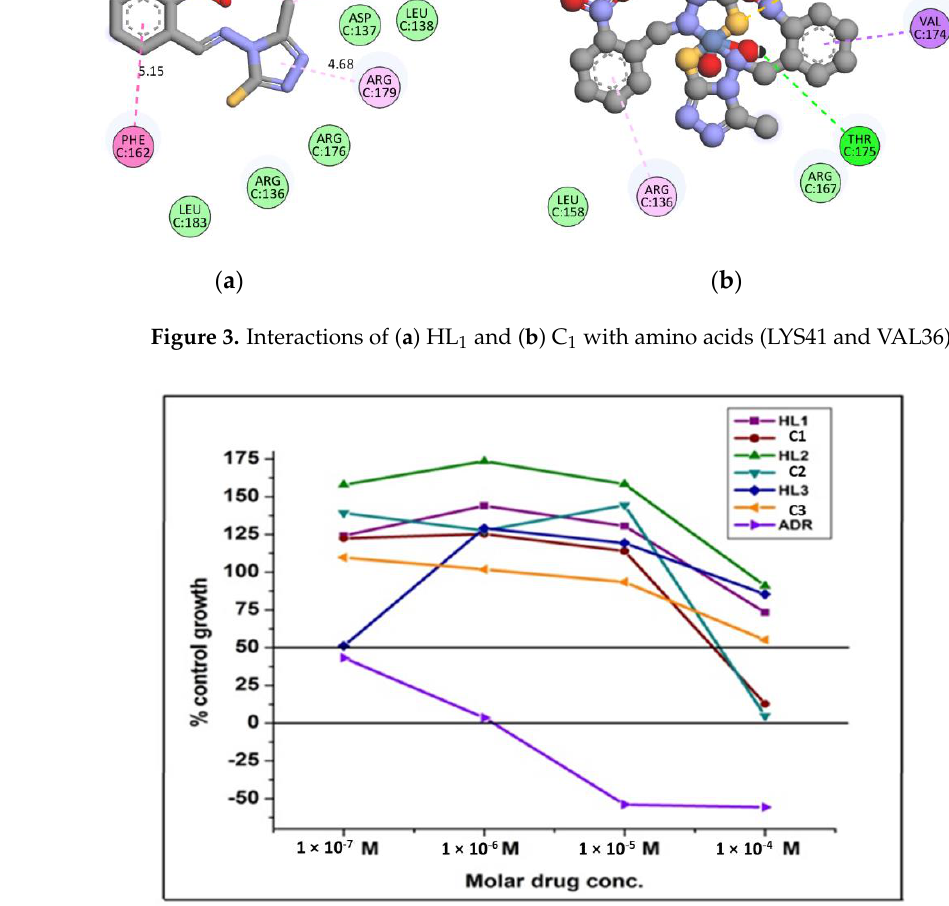
Table 10. Preliminary in vitro anticancer screening data of Schiff bases (HL 1 -HL 3 ) and their com- plexes (C 1 -C 3 ).